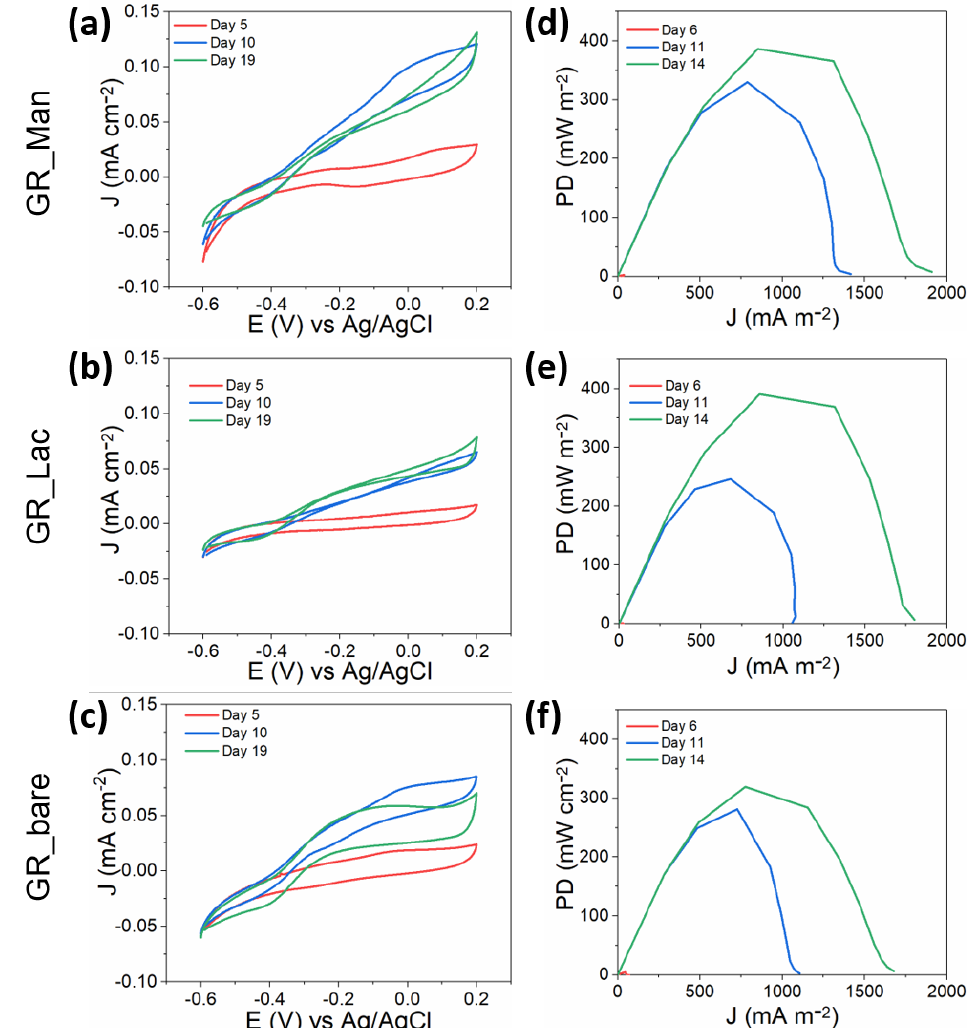
Figure 7. In situ CVs of graphite anodes of MFC devices equipped with GR_Man ( a ), GR_Lac ( b ), and GR_bare ( c ) anodes. CVs were obtained at 5 mV s −1 after day 5, day 10, and day 19 from the inoculum injection. The corresponding power density curves obtained at day 6, day 11, and day 14 for MFC devices equipped with GR_Man ( d ), GR_Lac ( e ), and GR_bare ( f ) are shown on the right hand side.